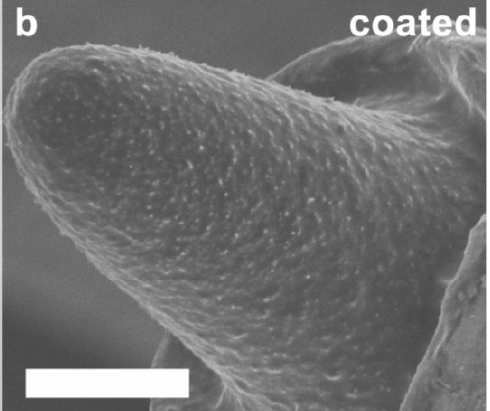
Figure 5. SEM images of representative uncoated ( a ) and PEDOT/MWCNT/Dex coated ( b ) electrode tips extracted from the brain after 11 days. Tips were cleaned using trypsinization and dried before imaging. Note intact coating with no visible cracks or spallation, and the presence of a dense biological film overlaying the coating. Scale bars = 3